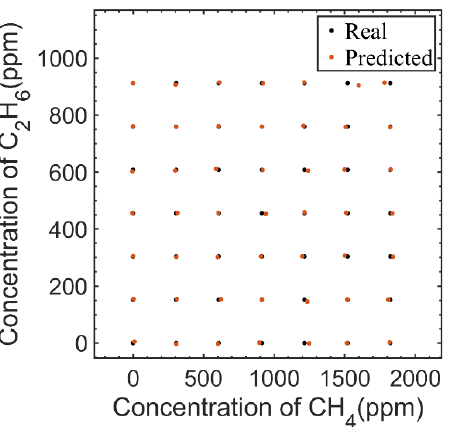
Figure 9. Predicted concentrations of CH 4 and C 2 H 6 using measured mixed